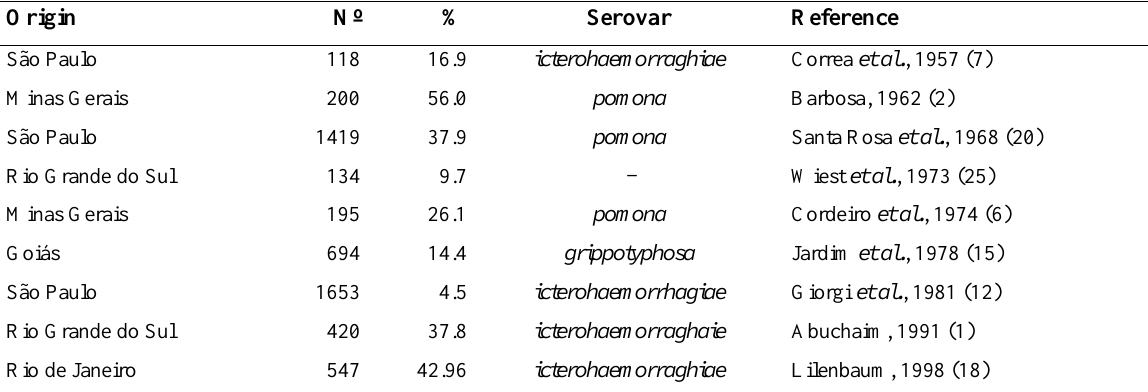
Table 3. Occurrence of anti- Leptospira agglutinins in equines, according to origin, number of animals, percentage of reagents, and most frequent serovar. Botucatu